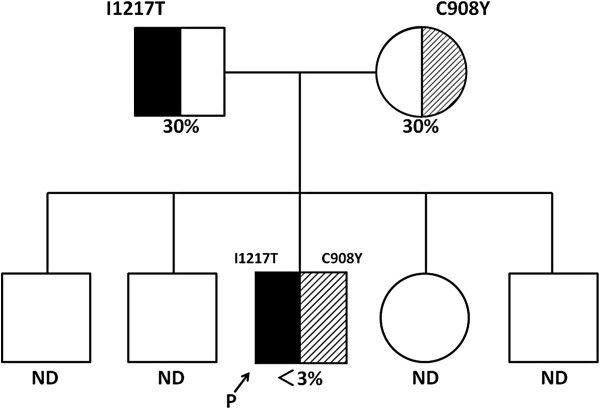
Pedigree of the index patient with genetic haplotypes and plasma activity of ADAMTS13 (a disintegrin and metalloprotease with thrombospondin type I domain 13). Squares represent males and circles represent females. Plasma ADAMTS13 activity (%) is shown under the circles and squares. Mutations of the ADAMTS13 gene are shown as one-letter amino acid abbreviations numbered from the initial Met codon. The arrow indicates the index patient. The mother and father of the index patient are both asymptomatic carriers. Abbreviations P: patient, ND: not determined.